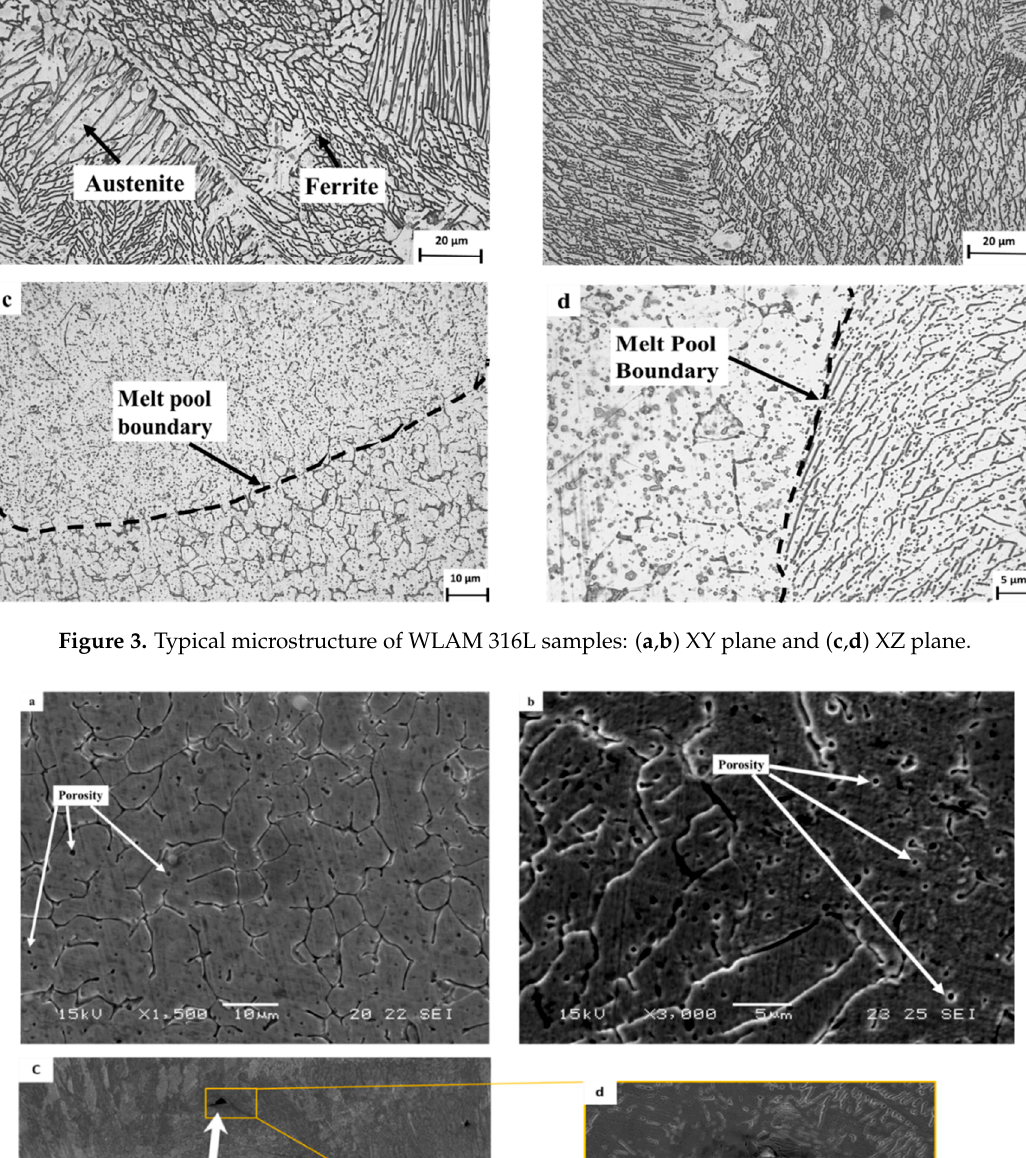
Figure 2. X-ray diffraction analysis of the WLAM 316L sample (in XY and XZ planes) and the counterpart AISI 316L alloy.